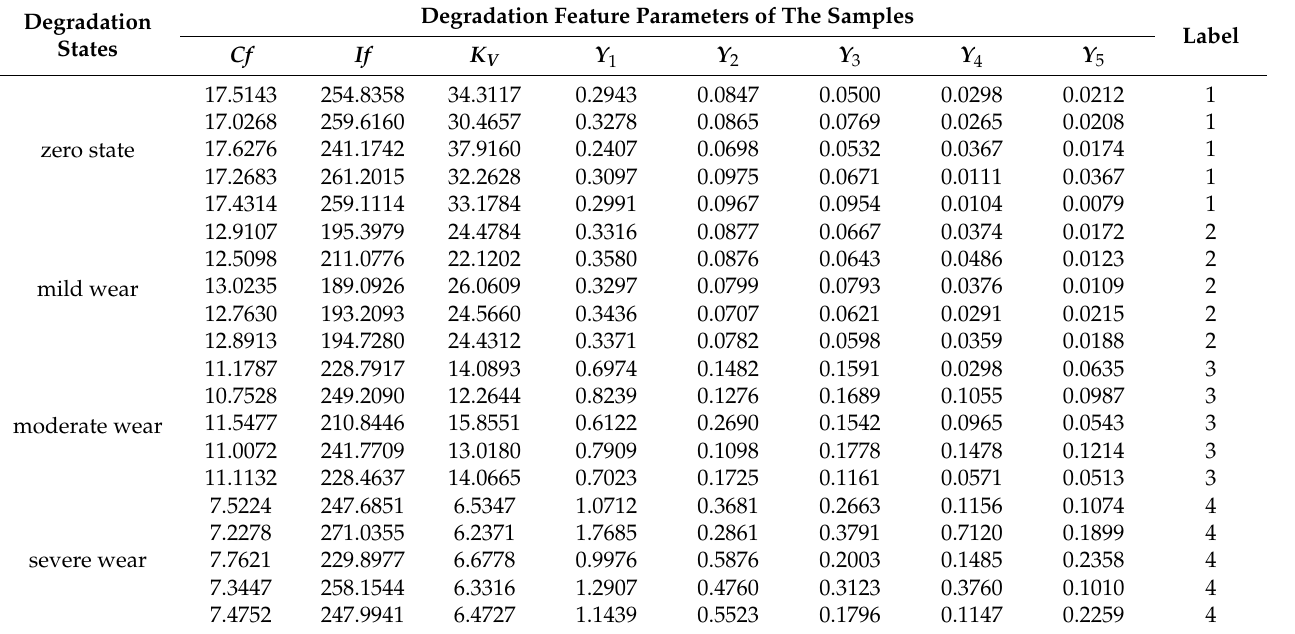
Table 3. Test samples and corresponding target feature